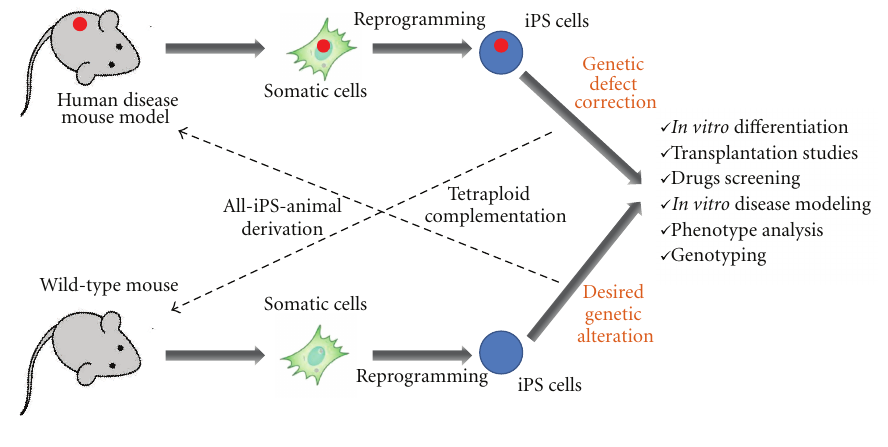
Figure 2: Mouse induced pluripotent stem cells applications for human disease mouse